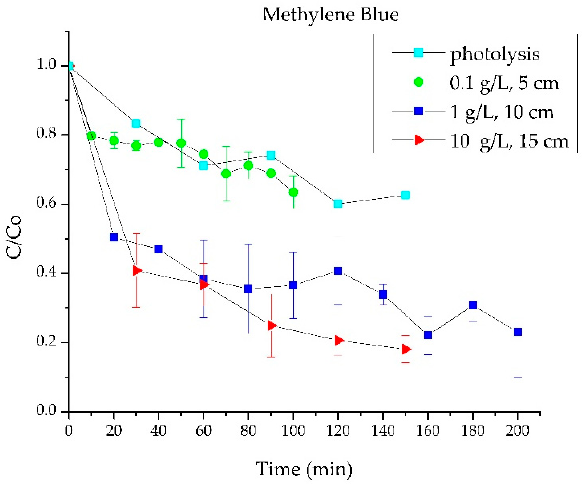
Figure 9. Degradation curves of Methylene Blue for different amounts of catalyst and irradiation time, under visible light irradiation. Photolysis of the pollutant is also included.